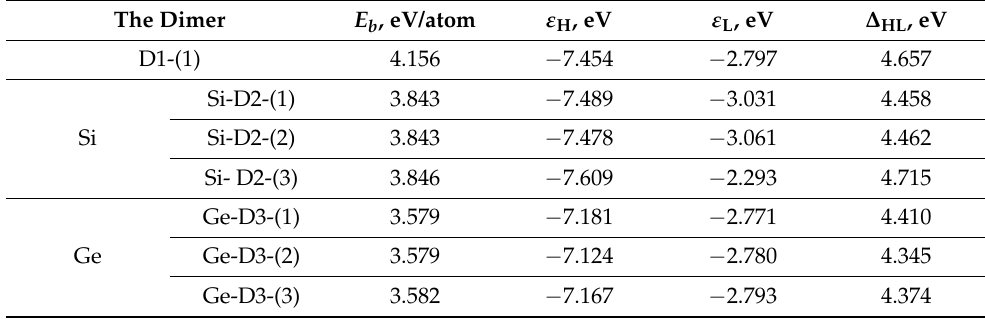
Table 4. The binding energies, HOMO–LUMO gaps, ε H and ε L energies of the dimers based on CL-20, Si 5 CL-20, and Ge 5 CL-20 molecules obtained at the DFT/B3LYP/6-311(d,p) level of theory. The